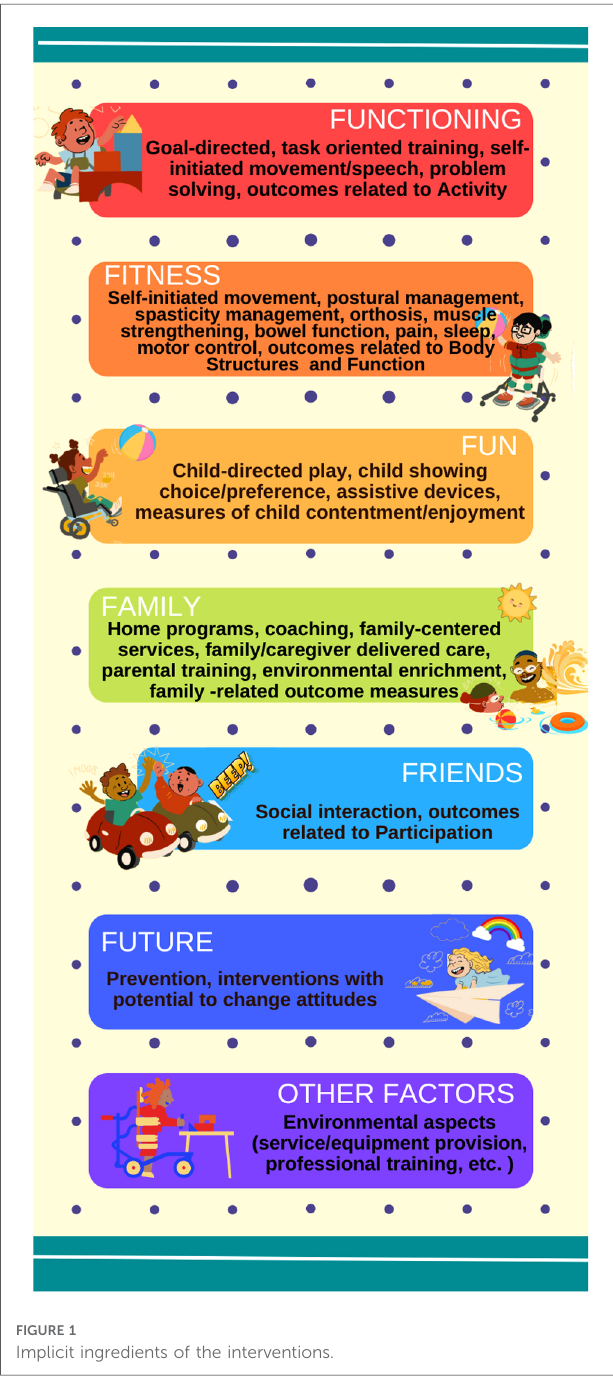
FIGURE 1 Implicit ingredients of the